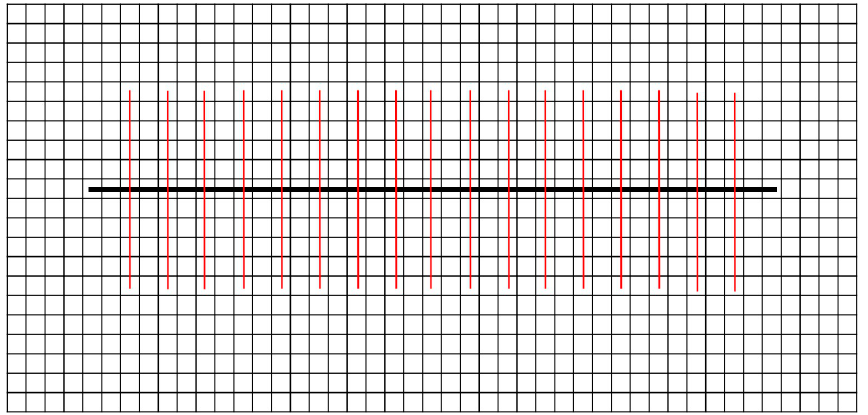
Figure 11. Simulated REV of shale reservoir used in simulation; bold black line in the middle is the horizontal well and red lines represent 17 stages of hydraulic fractures. Table 3. Reservior properties of studied REV.